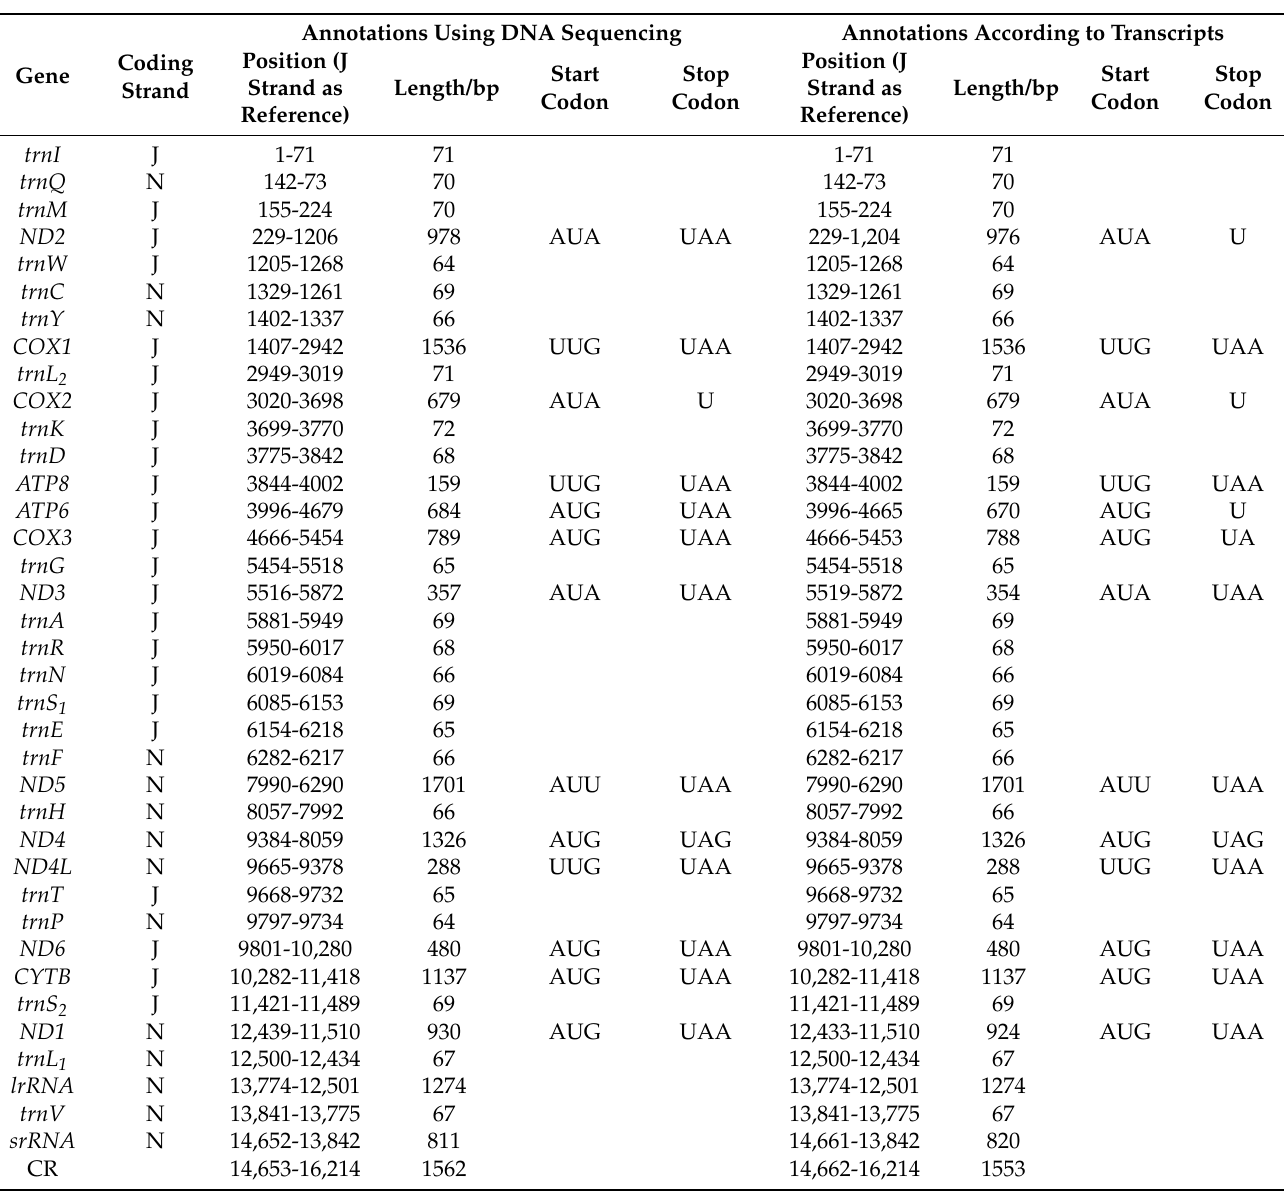
Table 1. The precise annotation of the C. chinensis mitogenome based on DNA sequencing and full- length transcripts. Abbreviations: ATP6 and ATP8 , adenosine triphosphate (ATP) synthase